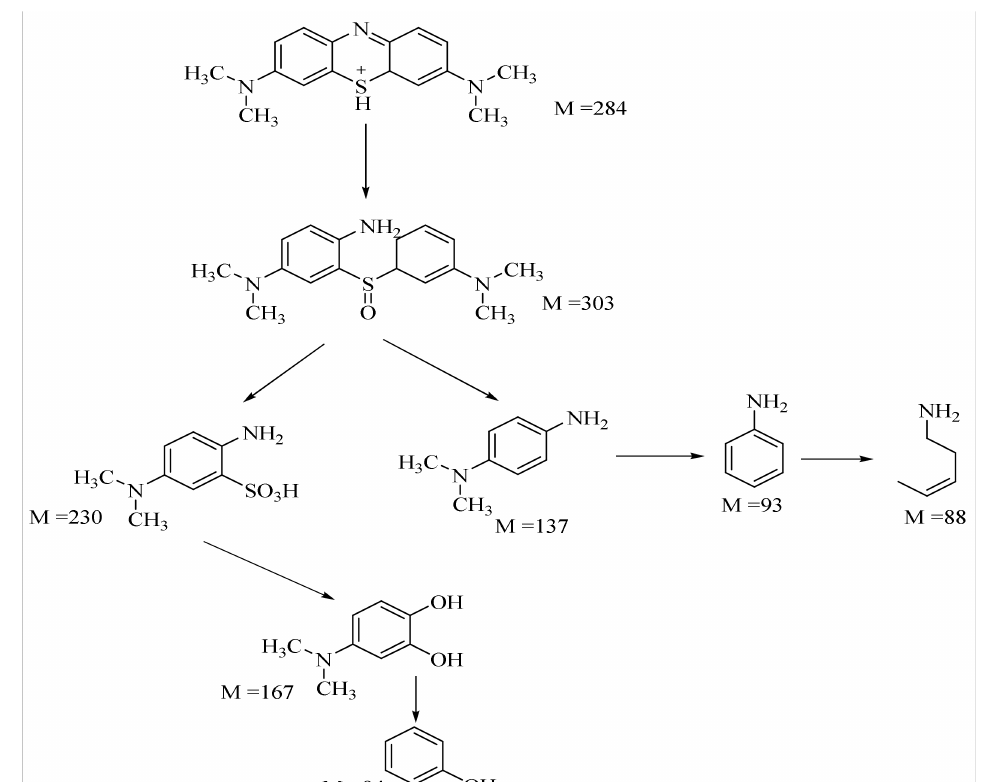
Scheme 3. Degradation pathway of methylene blue over CuS